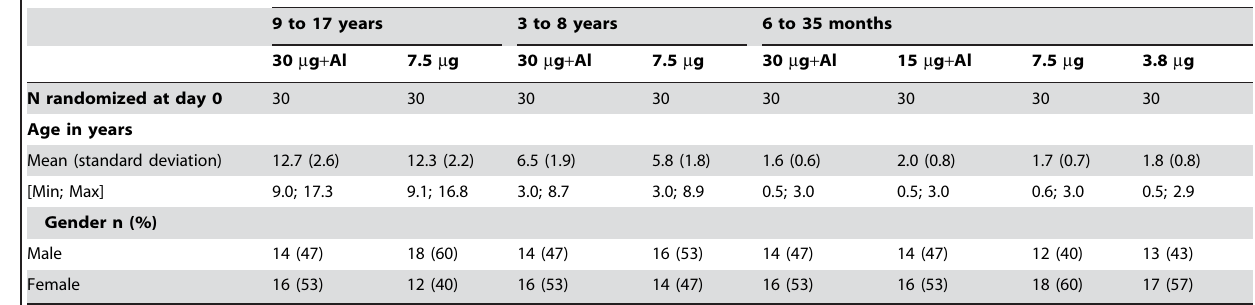
Age and vaccine formulation group: dose and adjuvant